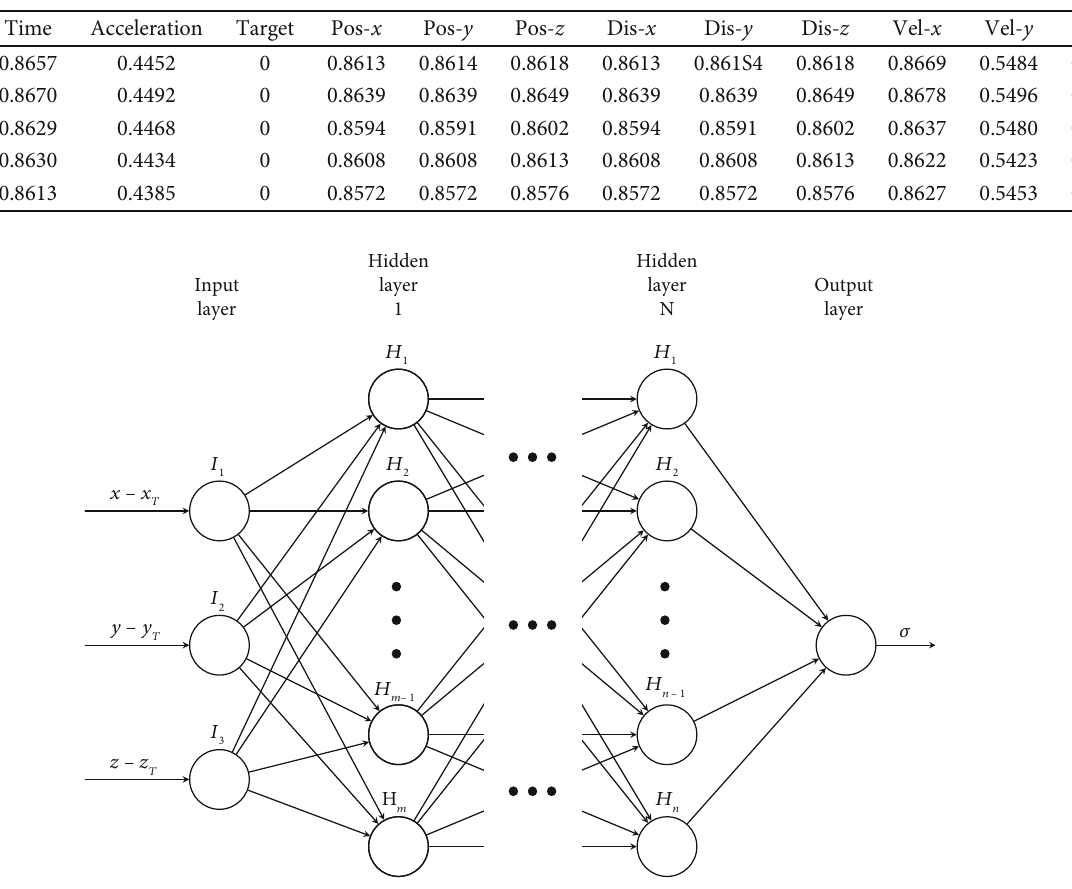
Figure 2: Neural network architecture example